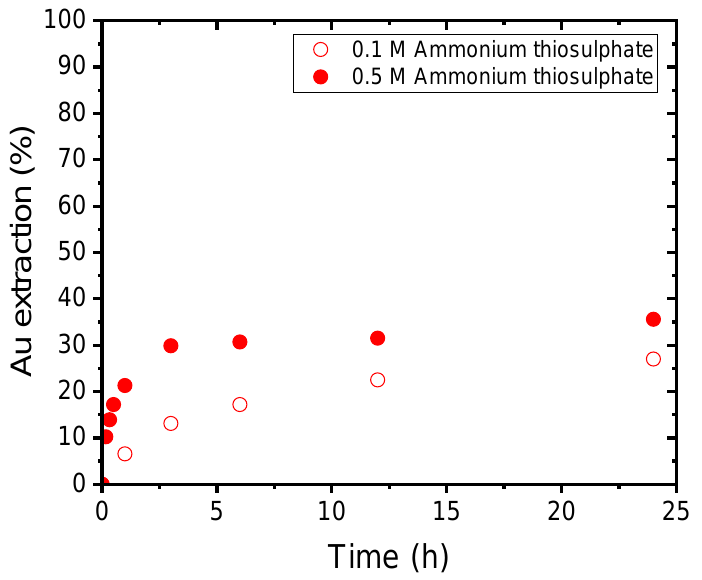
Figure 13. Effect of varying thiosulphate concentrations on gold extraction for Sample 1 at 0.5 M